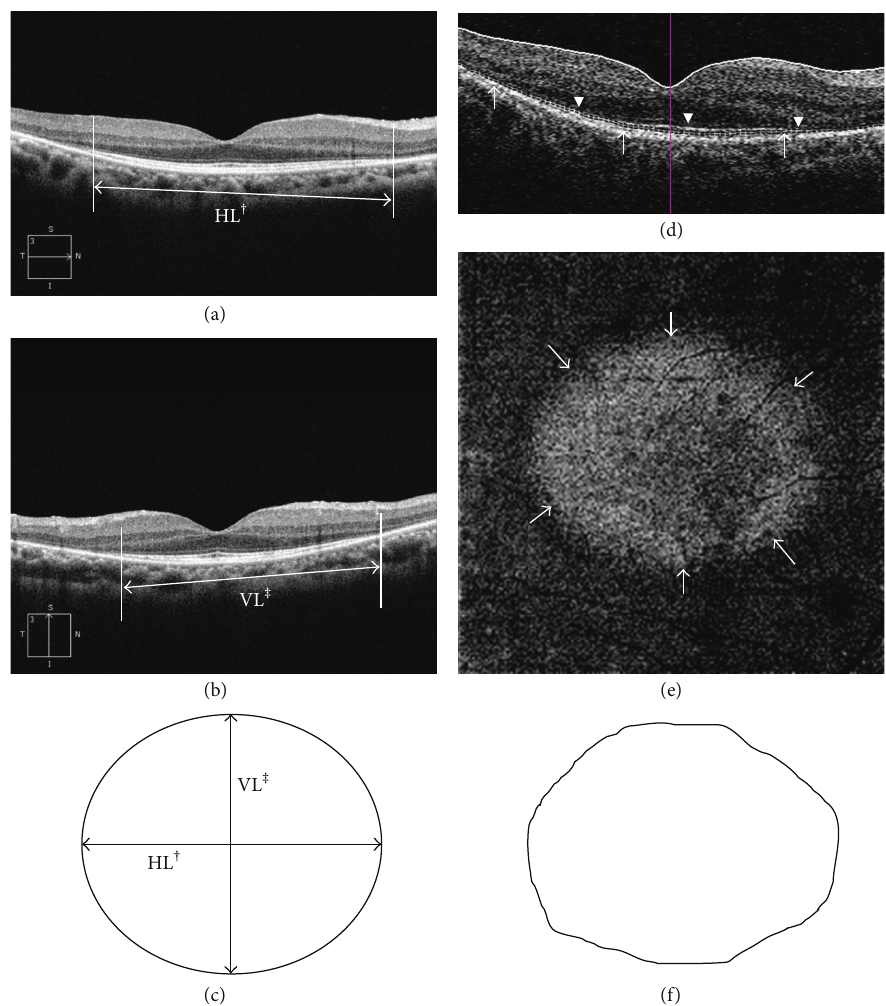
Figure 1: Representative image showing 2 methods for calculating the PROS area in the same patient. The PROS area measurement method using the horizontal and vertical PROS lengths of the high-definition (HD) scan is illustrated in (a)–(c), and the method using an en-face image of advanced visualization is demonstrated in (d)-(e). Horizontal HD scan (a) and vertical HD scan (b) of the same patient. The arrow indicates the PROS length ( † : horizontal PROS length and ‡ : vertical PROS length). The presumptive PROS area derived from the horizontal and vertical PROS lengths. Area of ellipsoid = 𝜋 × (horizontal length/2) × (vertical length/2) (c). Horizontal scan showing the slab layer (d). The dotted line marked by the arrowheads is the slab layer. The arrowheads indicate the photoreceptor IS/OS junction. An en-face image of the slab layer (e). The brighter region (surrounded by the arrows) is the preserved PROS area, and the darker region is the area where the PROS was not detected by OCT. Manual demarcation of the PROS area was carried out by using Photoshop CS 3.0 (f).